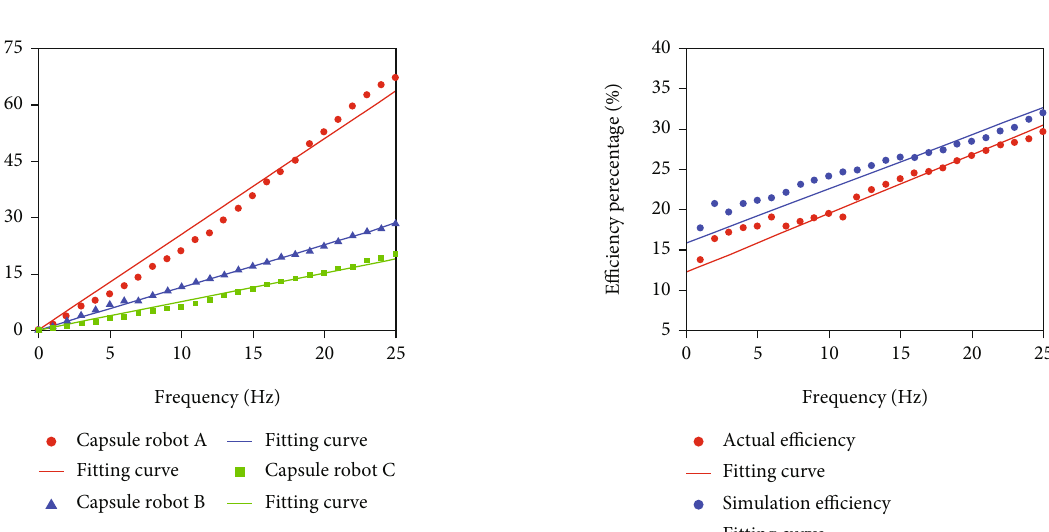
Figure 11: Relationship between frequency and velocity of capsule robot at di ff erent